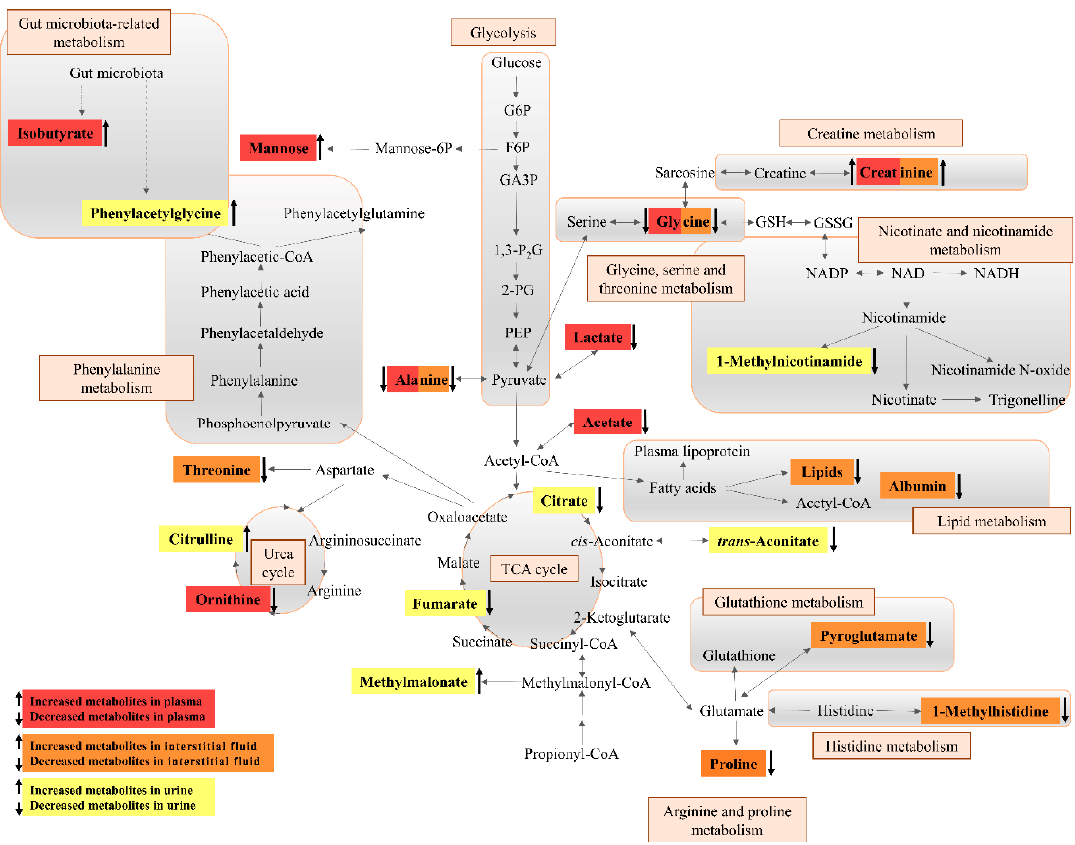
Figure 4. Simplified representation of metabolomic pathways, showing significantly altered metabolites in hypertensive patients compared to normotensive patients in plasma (red), interstitial fluid (orange), and urine (yellow).